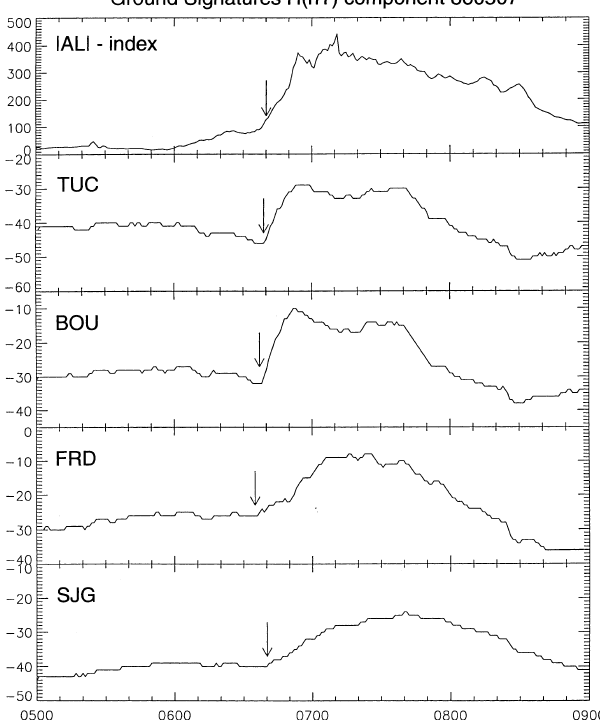
Fig. 6. The H-component magnetograms from four low-latitude stations, together with the |AL| index on May 7, 1986. The arrows indicate the onset time in each station Fig. 7. The D-component variations (in nT) from low-latitude stations and from GOES satellites as well, for May 7, 1986. TUC is the most westward point of our chain, while SJG is the most eastward. The vertical line corresponds to the substorm